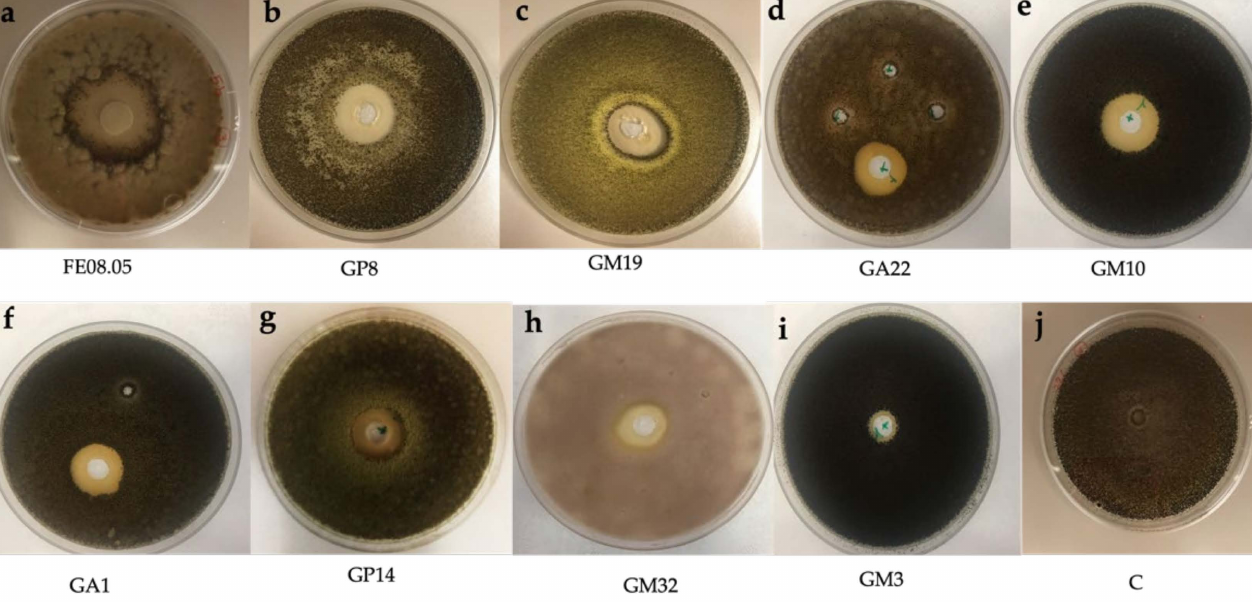
Figure 5. Mycelial growth inhibition of 9 different isolated yeast on Aspergillus carbonarius . ( a ) Starmerella bacillaris FE08.05, ( b ) Metschnikowia pulcherrima GP8, ( c ) Hanseniaspora uvarum GM19, ( d ) Hanseniaspora opuntiae GA22, ( e ) Hanseniaspora opuntiae GM10, ( f ) Hanseniaspora guilliermondii GA1, ( g ) Hanseniaspora pseudoguilliermondii GP14, ( h ) Hanseniaspora lanchancei GM32, ( i ) Candida awuaii GM3. ( j ) Negative control (C) filled with NaCl saline solution (0.9%